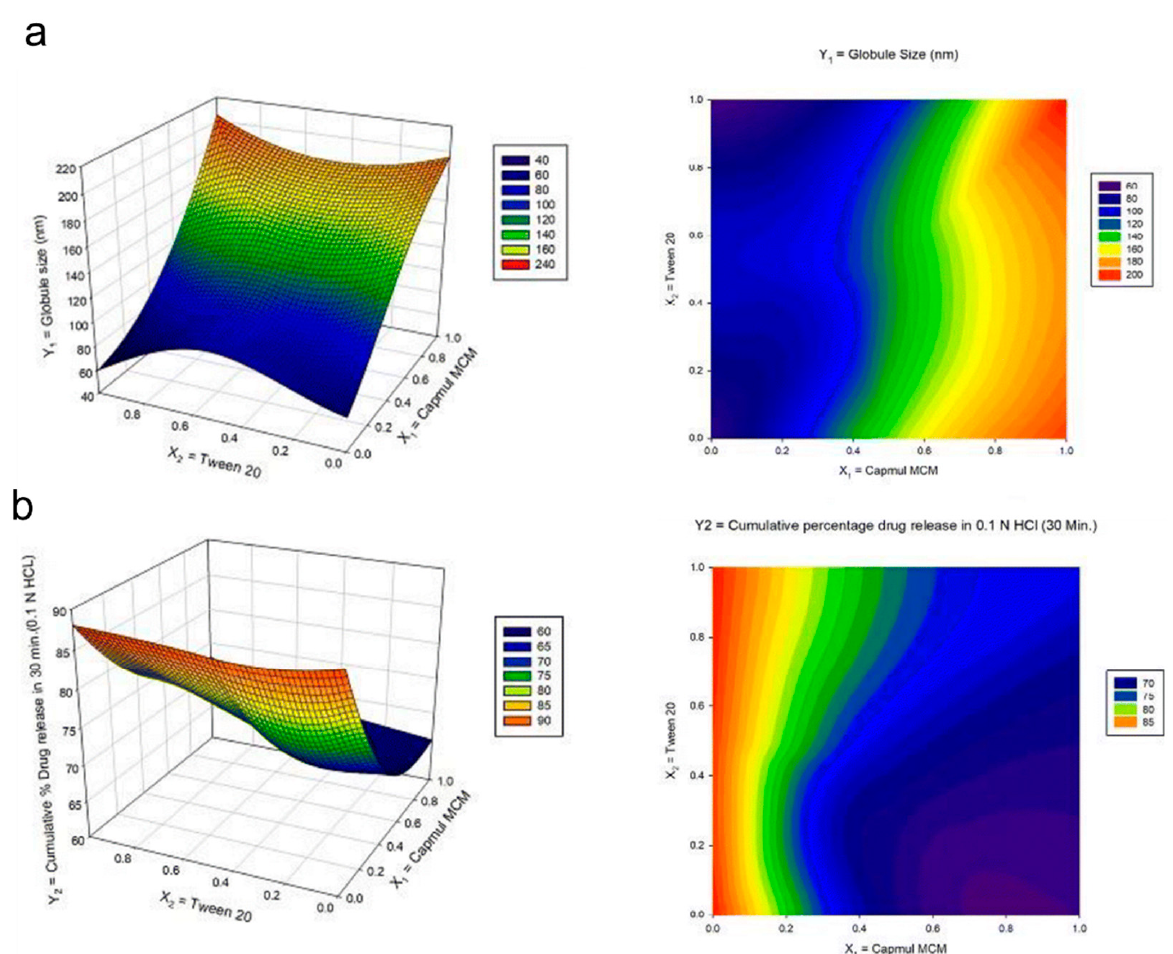
Figure 6. Response surface plot in three-dimension (3D) (left) and the contour plot (right) for the mixture design of the ( a ) globule size and ( b ) cumulative drug release in pH 1.2 media from the study of clofazimine in solid SMEDDS by Dhaval and coworkers. Adapted from Dhaval and coworkers [94].